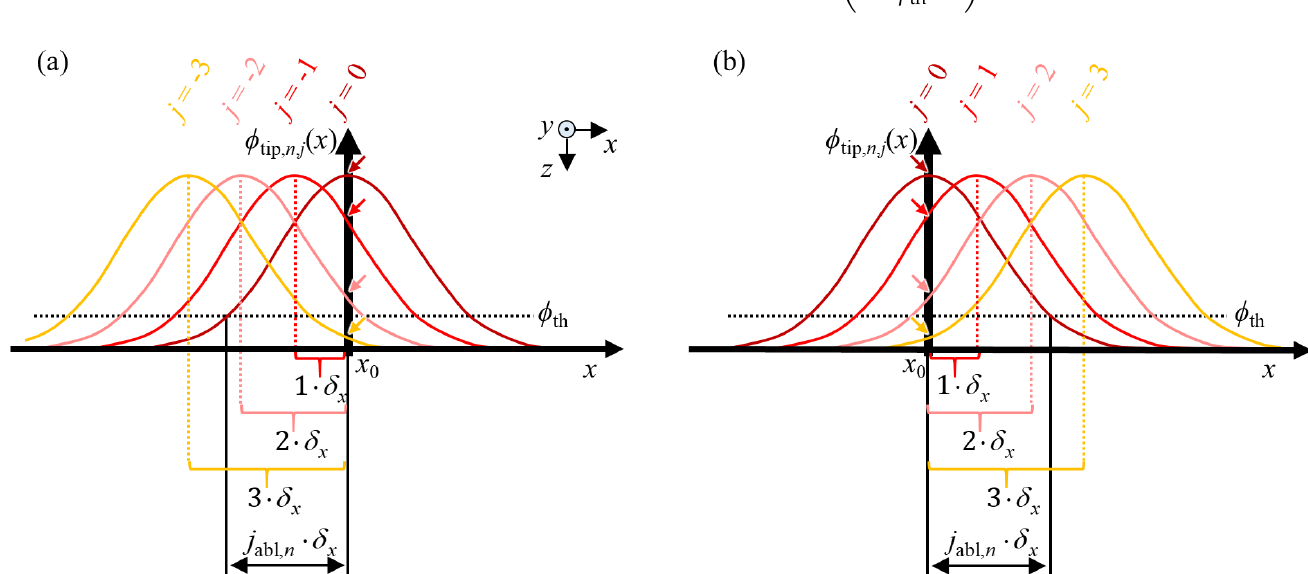
Figure 2. Absorbed fluence distributions ϕ tip, n , j ( x ) along the x axis at y = 0 of the incident pulses ( a ) from j = − 3 to j = 0 and ( b ) from j = 0 to j = 3. The coloured small arrows indicate the absorbed fluence at the location x 0 . The intersection of the fluence distributions ϕ tip, n , j ( x ) with the ablation threshold ϕ th determines the maximum number of pulses j abl, n contributing to ablation in this direction along the x axis.